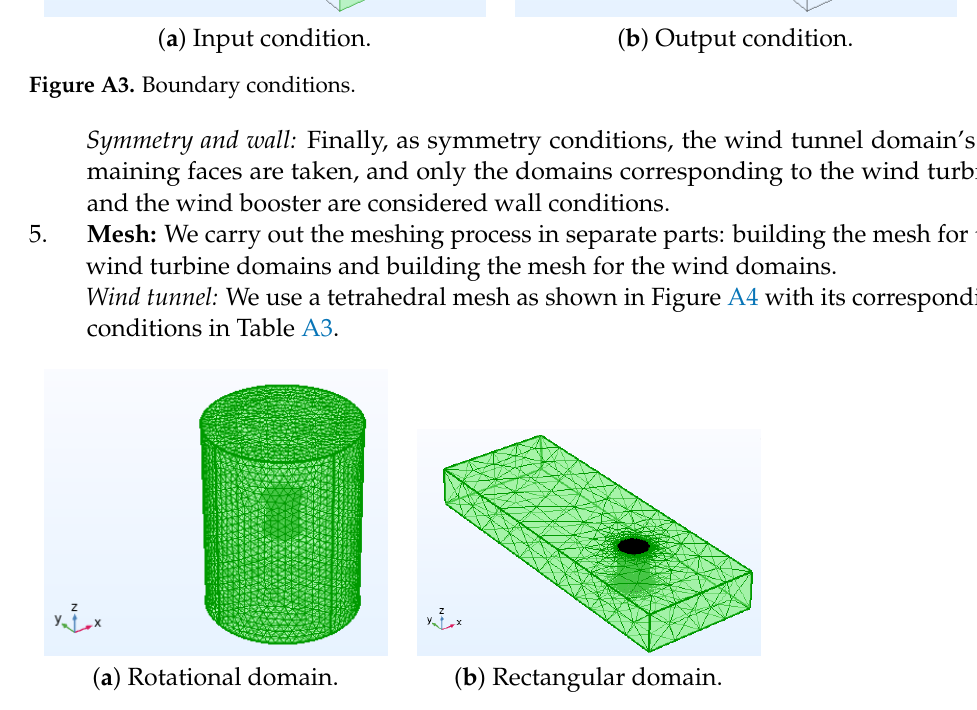
Figure A4. Wind Tunnel Mesh.